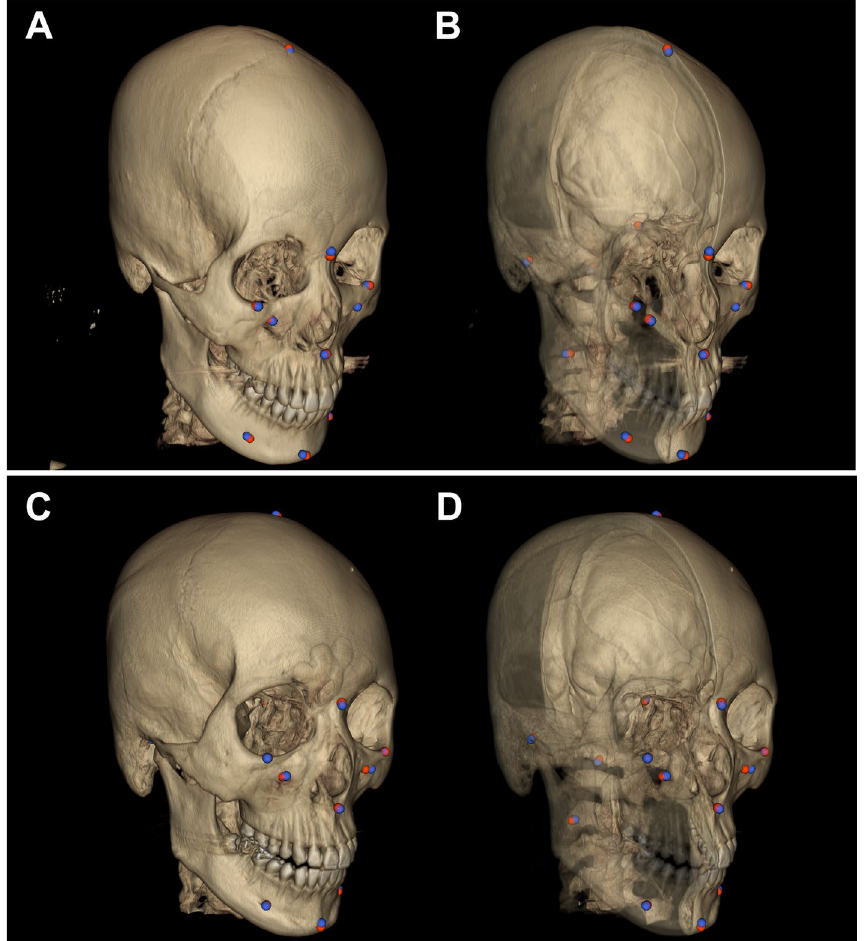
Figure 6. The best and worst landmark prediction results from the test group. A and B were from Subject 1 (Table 2), which showed the best prediction result of 1.57 ± 0.55 mm in prediction error, while C and D were from Subject 8, with the worst prediction result (2.41 ± 0.97 mm). The red ball points on and in the skull were produced by the experts and the blue ones by our DRL system. The right half of the skull for each subject is translucent to show the location of predicted